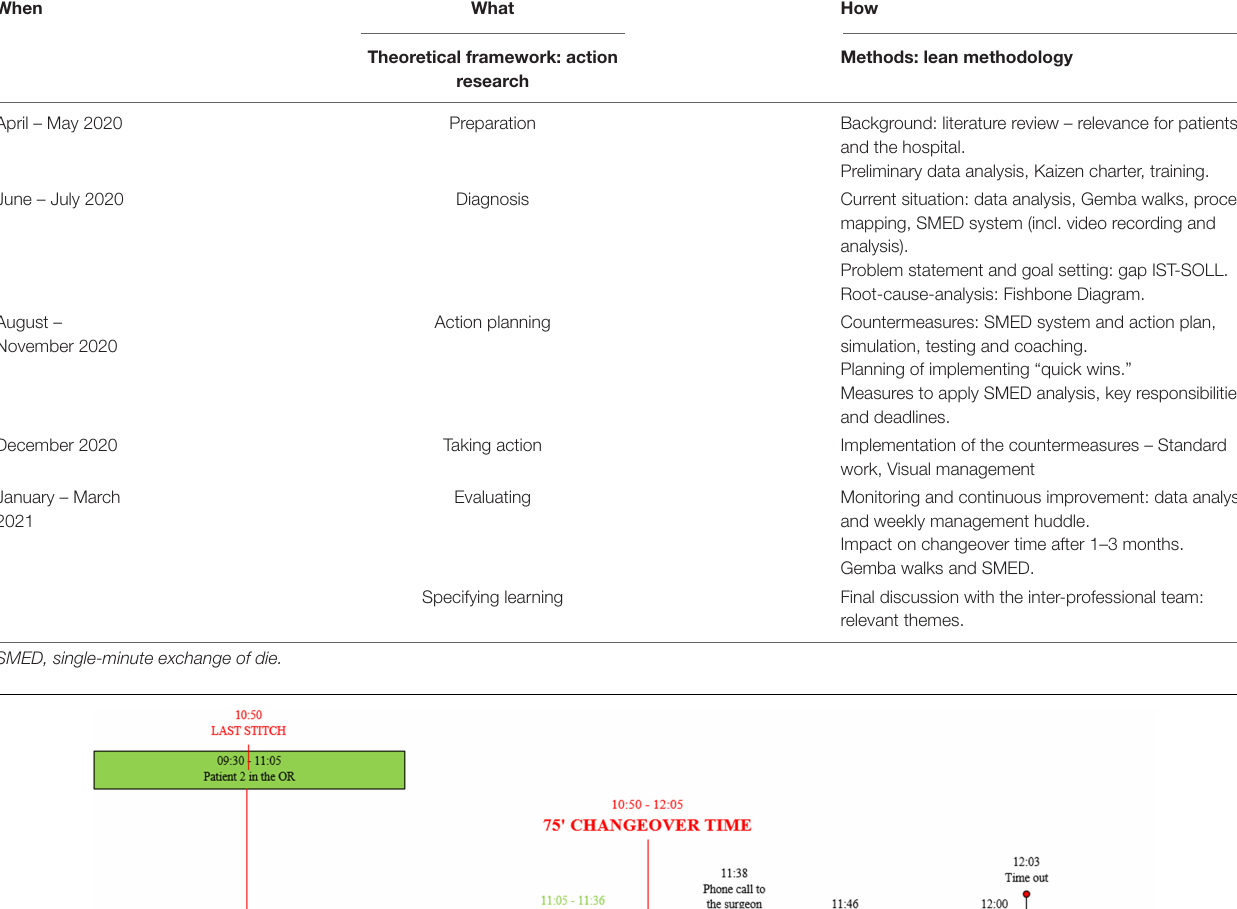
TABLE 1 | Theoretical framework and methods. When What How Theoretical framework: action research